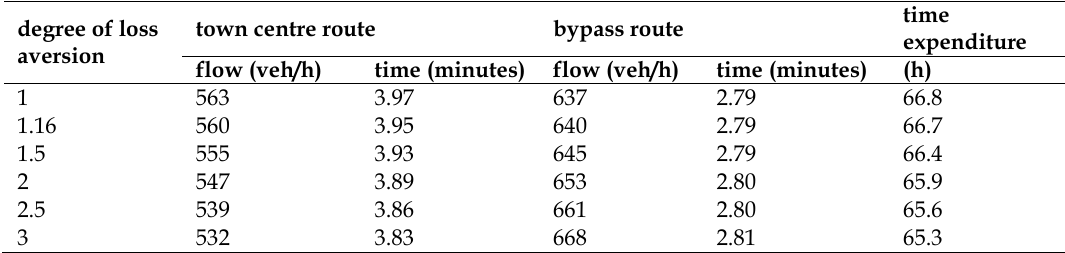
Table 4. RDSUE results with no toll: sensitivity to loss aversion in the time attribute